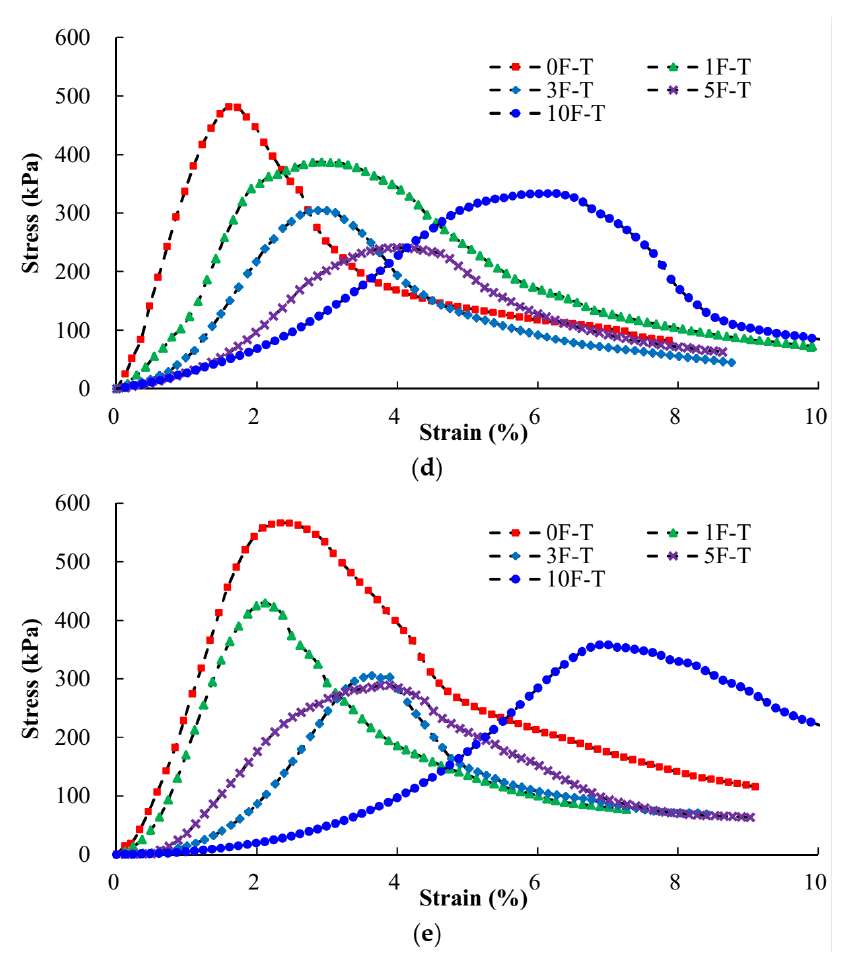
Figure 5. Stress–strain curves of different F–T cycles. ( a ) 0% fiber; ( b ) 0.25% fiber; ( c ) 0.5% fiber; ( d ) 0.75% fiber; ( e ) 1%